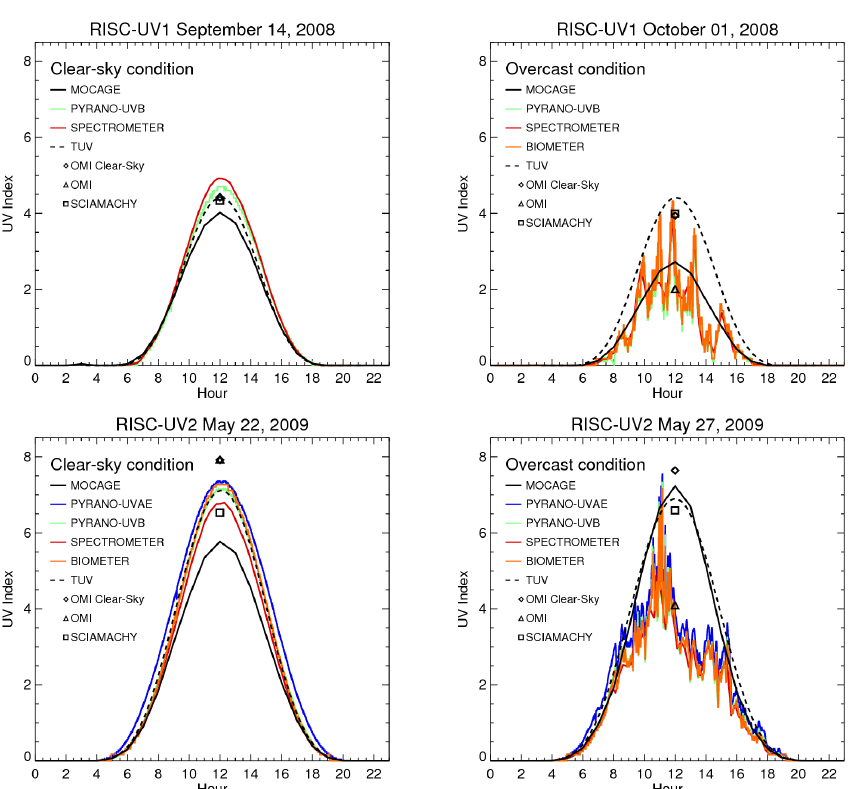
Fig. 4. Daily evolution of the UV index in clear-sky (left) and overcast (right) conditions during the RISC-UV campaign 2008 (top) and 2009 (bottom). MOCAGE simulation is compared to the SIRTA instruments (PYRANOMETER UVAE, PYRANOMETER UVB, SPECTROM- ETER, BIOMETER) and to the noon UV index values observed by the OMI (clear-sky and all-sky data) and SCIAMACHY (clear-sky data)